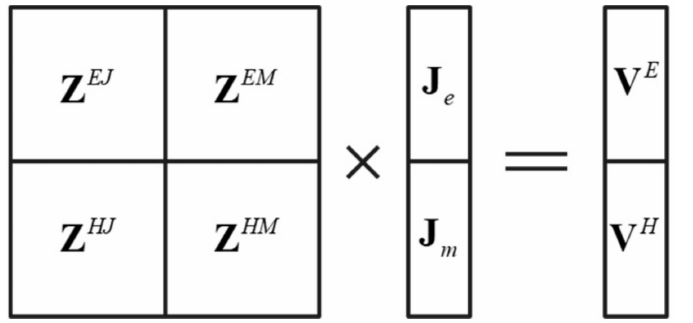
Figure 3. The structure of the impedance matrix of the PMCHWT